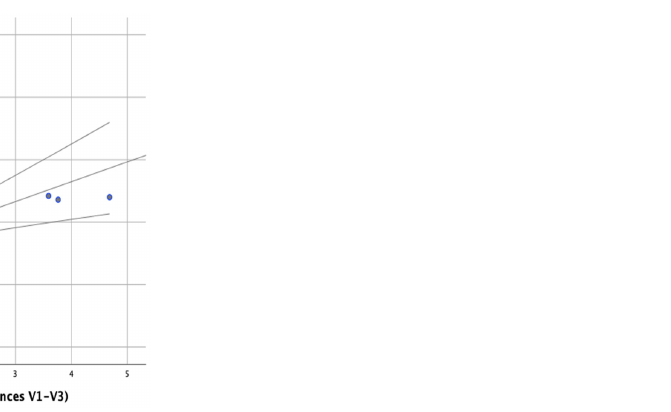
Figure 5. Correlations between differences in BMI and changes in serum TSH levels (between ini- tial visit V1 and final visit V3).